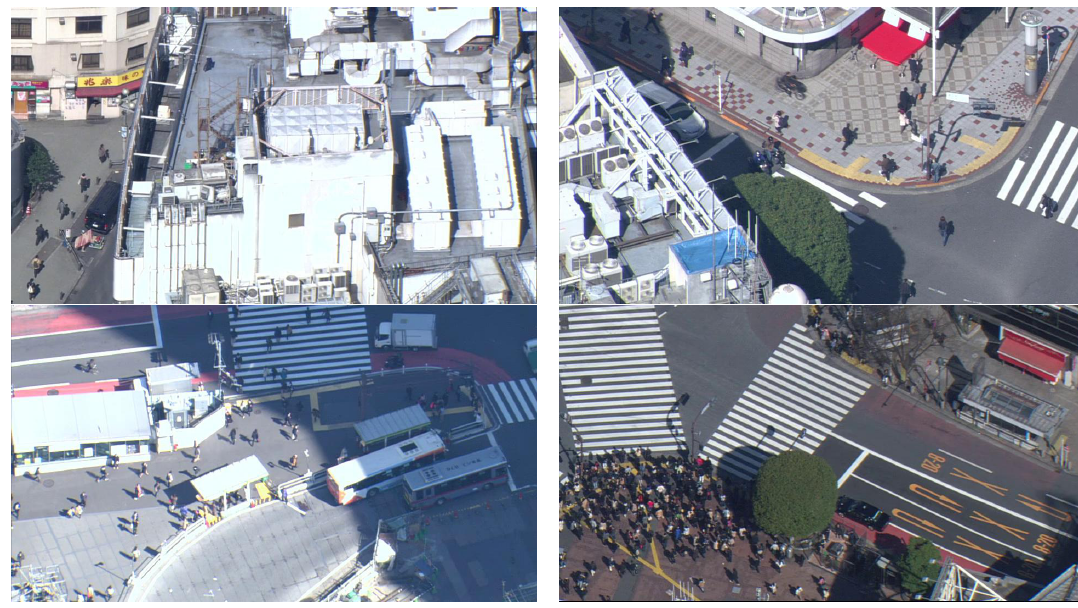
Figure 4. Sample images from TH2020